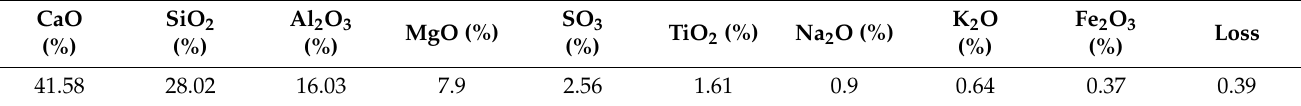
Table 5. The chemical composition of mineral